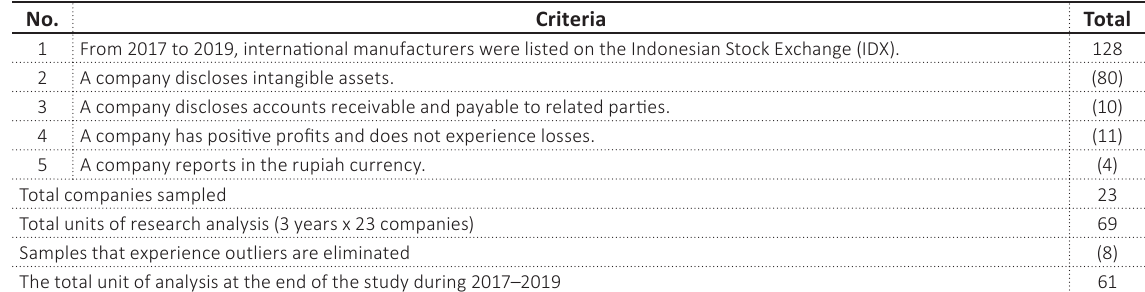
Table 1. Research sample